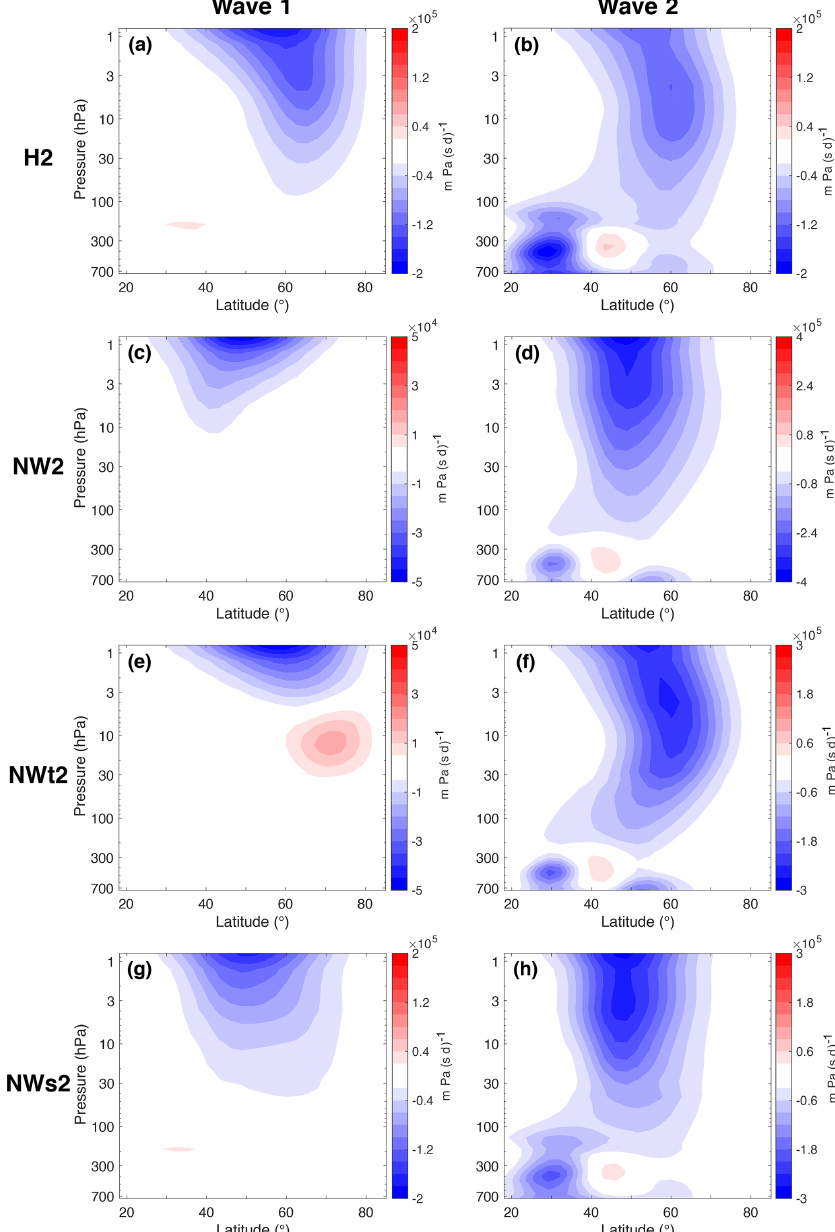
Figure 6. Vertical component of EP flux ( F p ) for H2 (a, b) , NW2 (c, d) , (e, f) and NWs2 (g, h) . (a, c, e, g) Wave 1 components. (b, d, f, h) Wave 2 components. Values are scaled by p 0 /p , where p 0 = 1000hPa. Contour intervals are 20 (a, b, g) , 5 (c, e) , 40 (d) and 30 (f, h) (in kmPa ( sd ) − 1